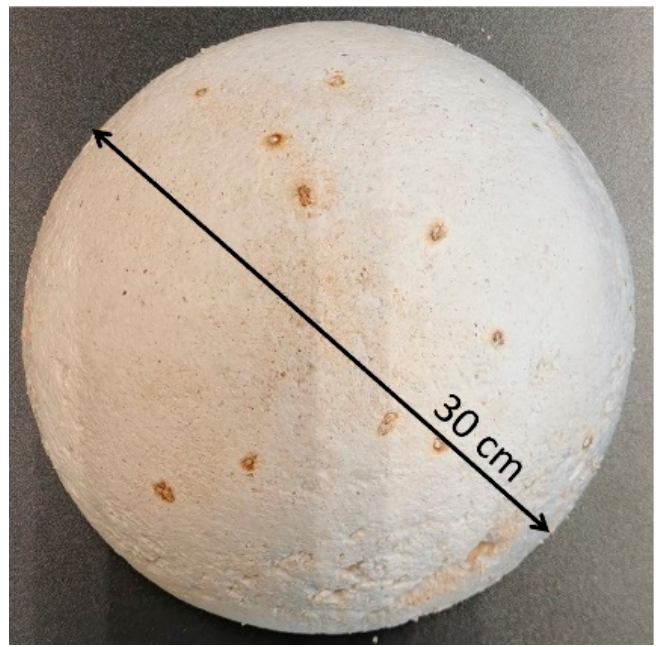
Figure 1. The sample used in test A (photo by A.B.).